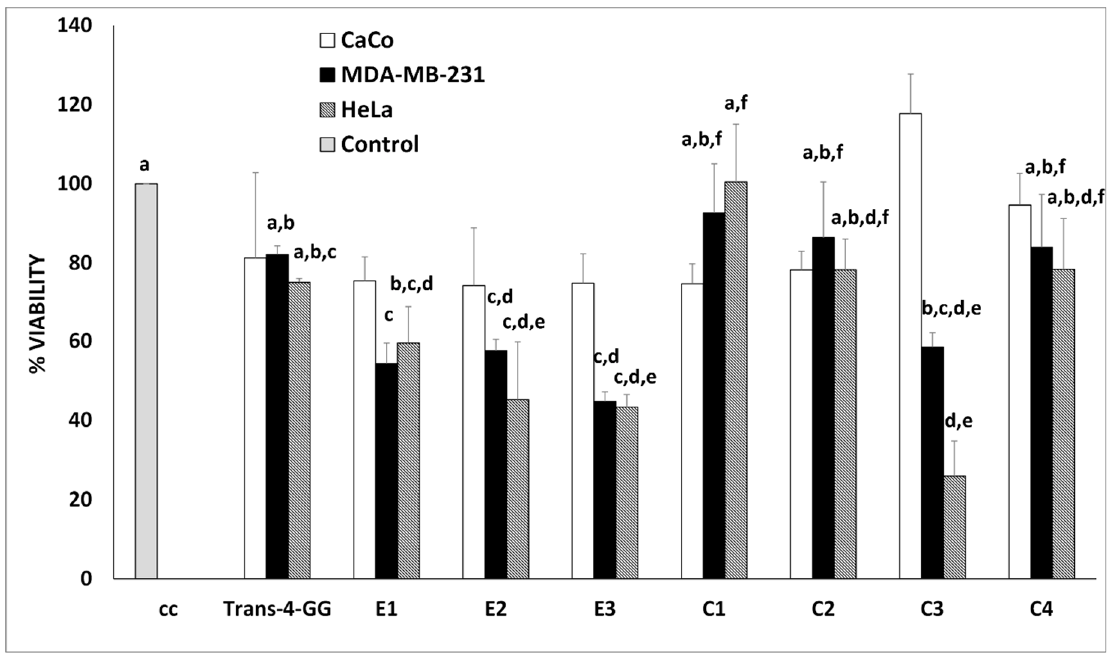
Figure 3. Antiproliferative effects (MTT assay) of a standard of trans ‐ 4 ‐ GG (2 μ M) and of the crocin ‐ rich extracts from cheese on CaCo2, MDA ‐ MB ‐ 231 and HeLa cells models. Data are expressed as percentage of viability cell and presented as mean ± SE of three independent experiments, each conducted in triplicate. Different letters (a–f) mean significant differences ( p < 0.05).